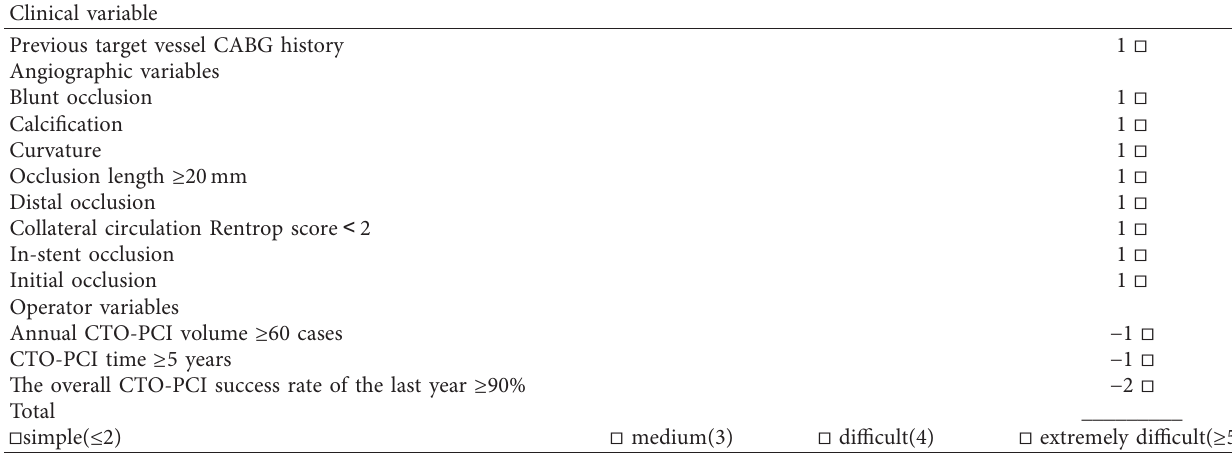
Table 2: Operator-CTO score.